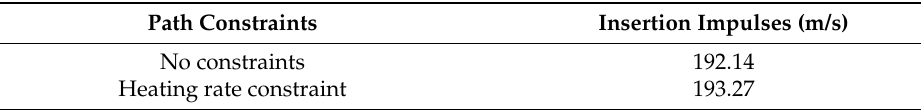
Figure 8. Velocity vs. flight path angle profiles with different path constraints. Table 3. Insertion impulses for different path